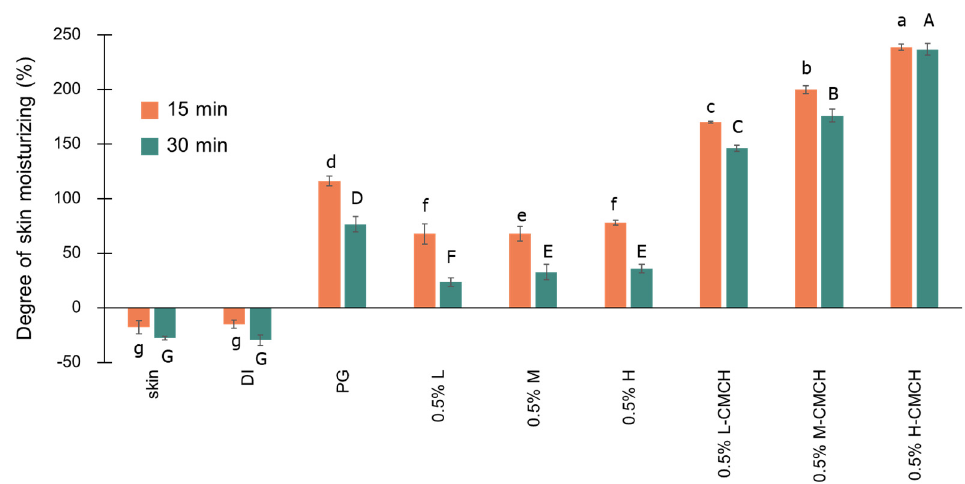
Figure 5. Degree of skin moisturizing (%) as affected by time (15 and 30 min) and different treatments (skin, DI, PG, L, M, H, L-CMCH, M-CMCH and H-CMCH) on pork skin Different lowercase letters (a-g) indicate significant differences between solutions at 15 min and different uppercase letters (A-G) indicate significant differences between solutions at 30 min.